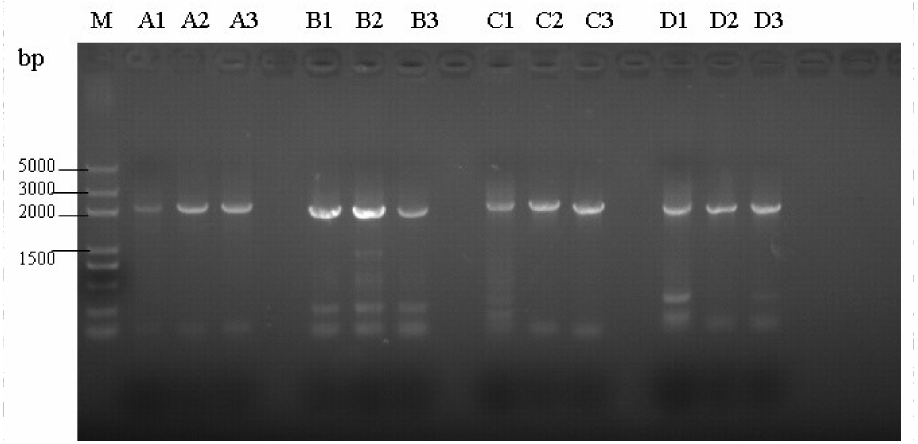
Figure 1. PCR amplification of the complete genomes of 3 isolates. M: DNA marker DL5000; 1–3: GDFX0601, GDFX0602, and GDFX0603; A, B, C, D: 4 DNA fragments of the complete